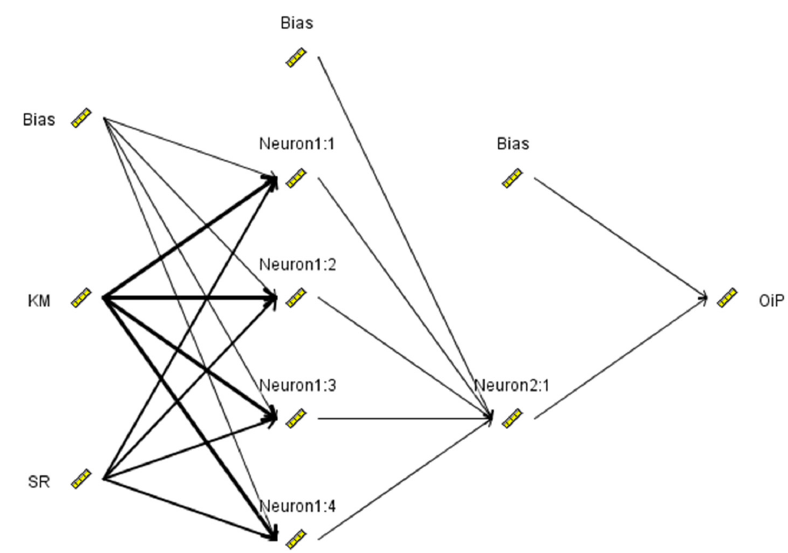
Figure 4. The MLP (4,1) network.